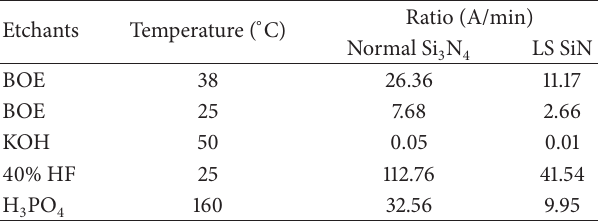
Table 3: LPCVD nitride etching rate comparison.